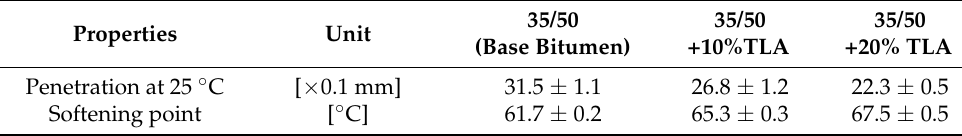
Table 3. Physical properties of TLA-modified binders after RTFOT